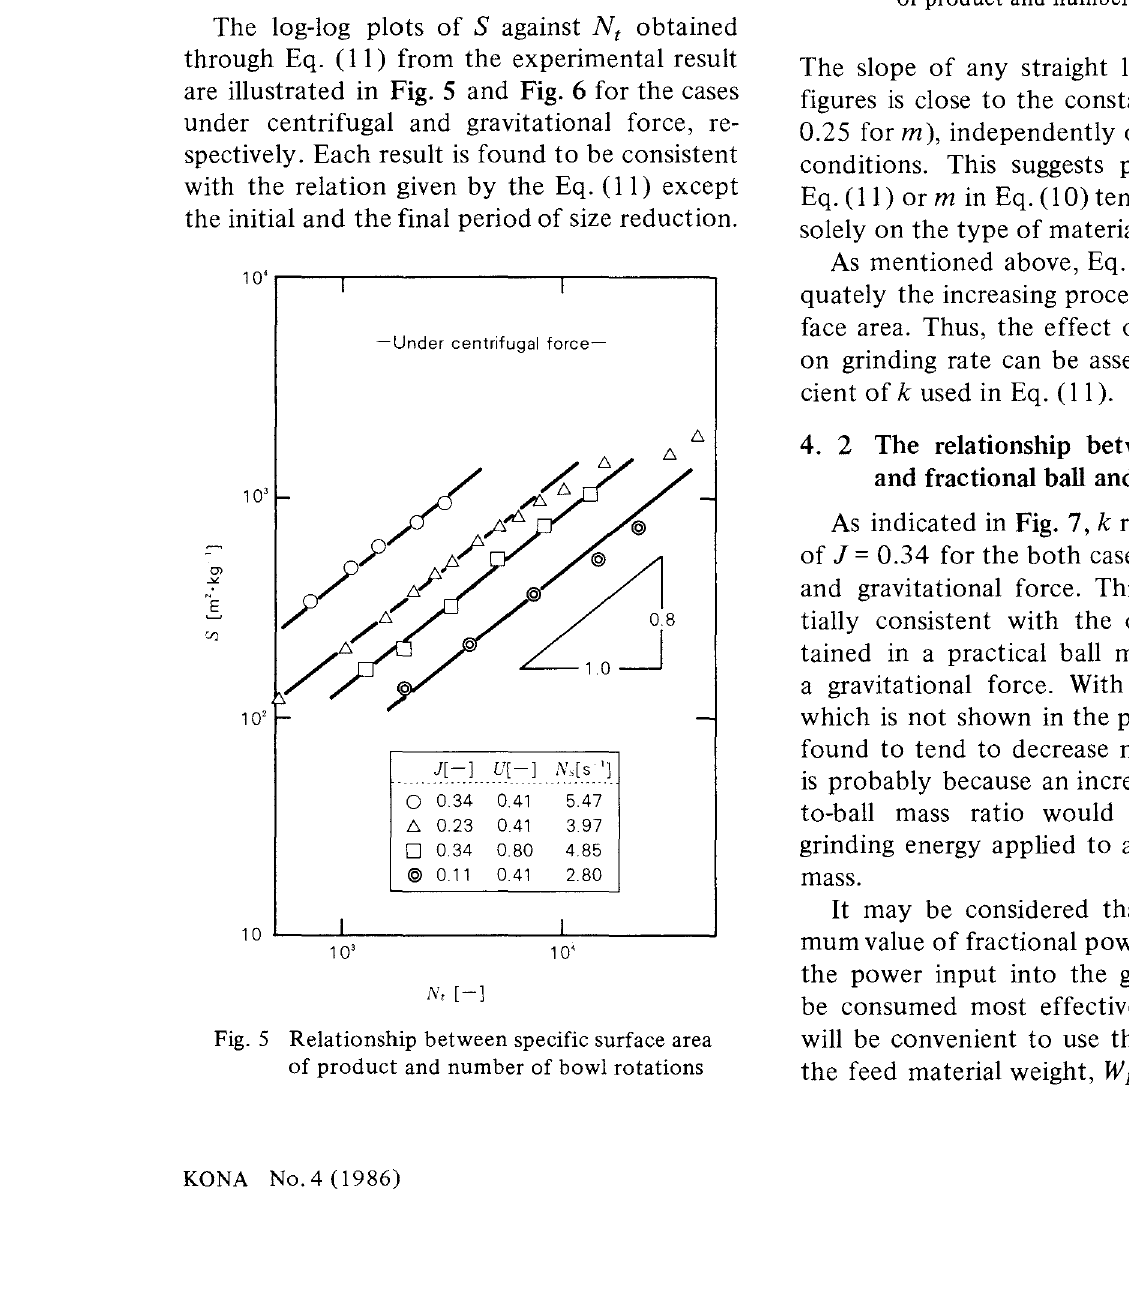
Fig. 6 Relationship between specific surface area of product and number of bowl